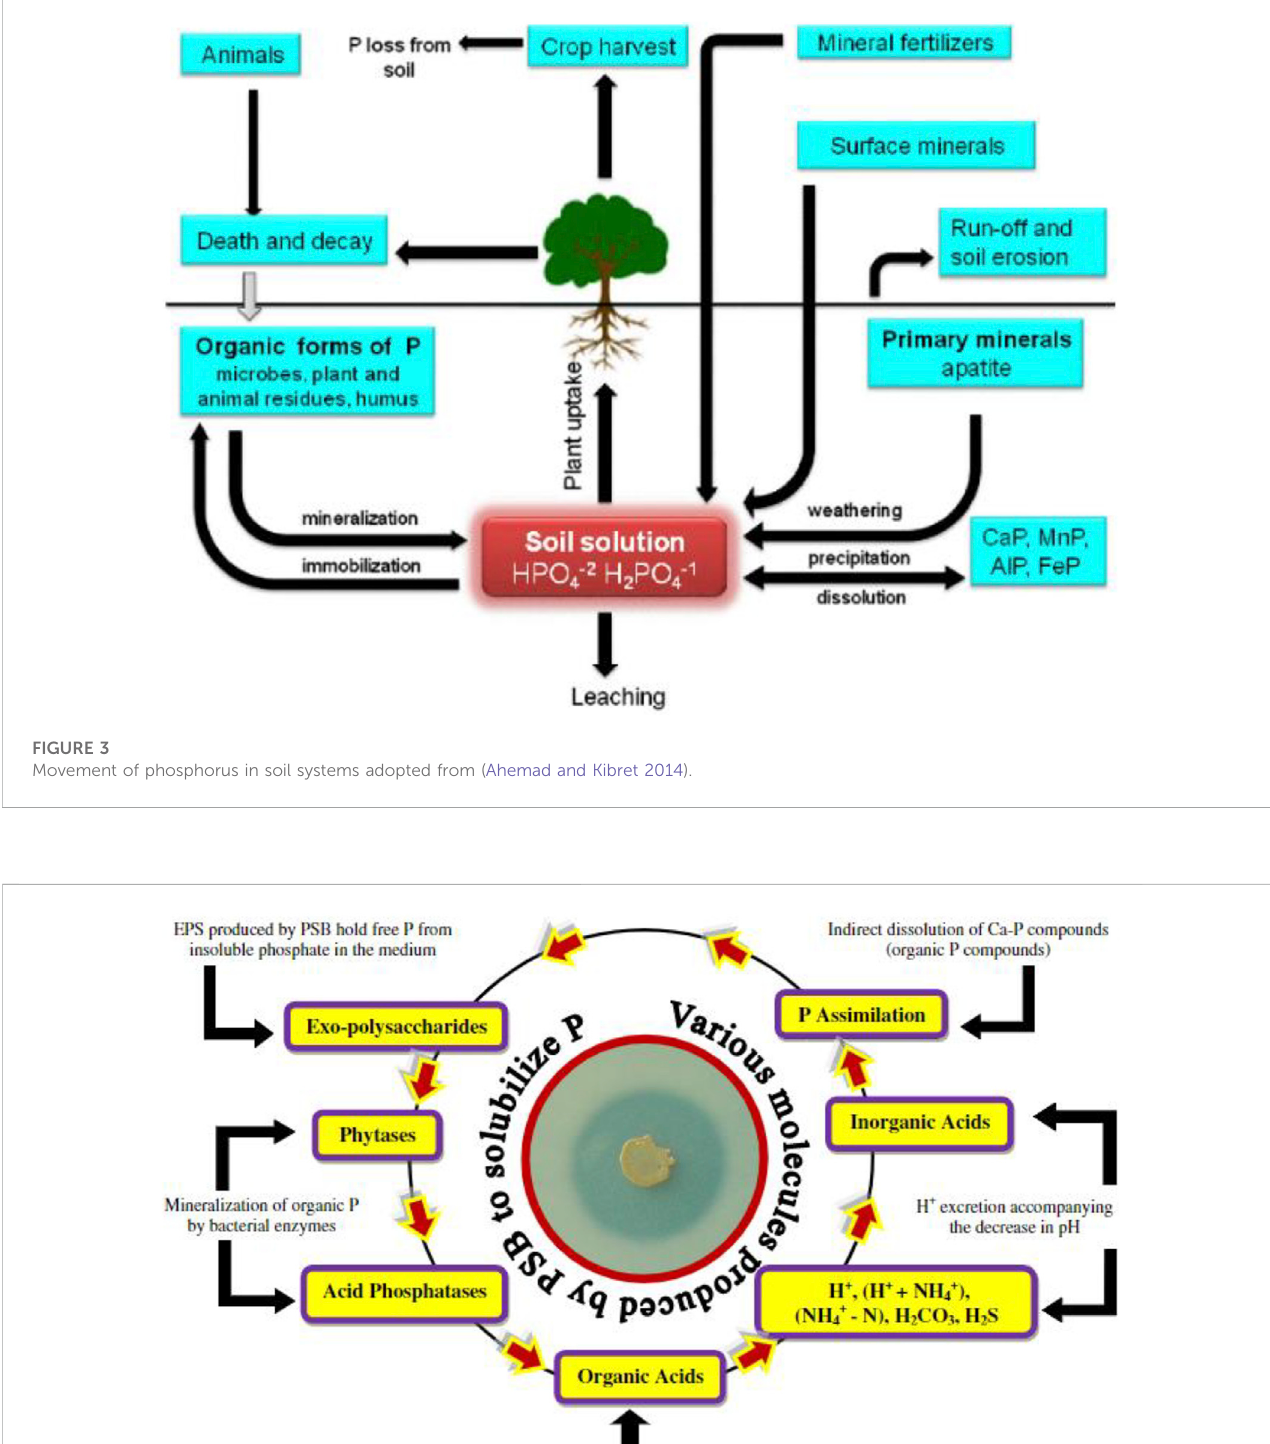
Frontiers in Bioengineering and